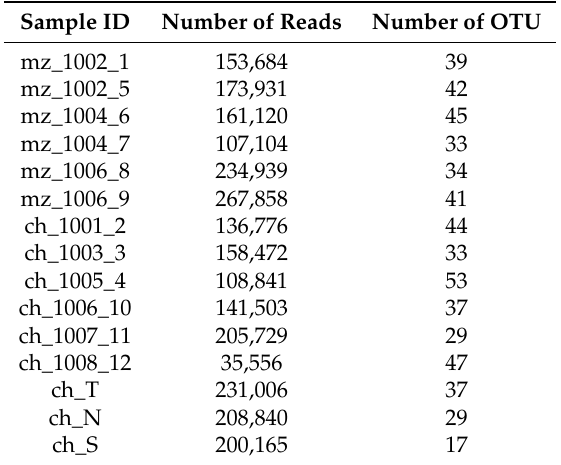
Table 2. ITS rRNA raw reads and diversity indices per